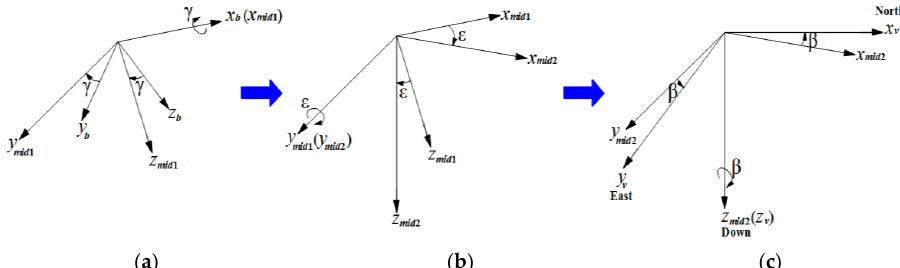
Figure 5. The coordinate frames relation: roll-pitch-yaw rotation sequence between body and vehicle frames. ( a ) body frame; ( b ) intermediate frame; ( c ) vehicle frame.